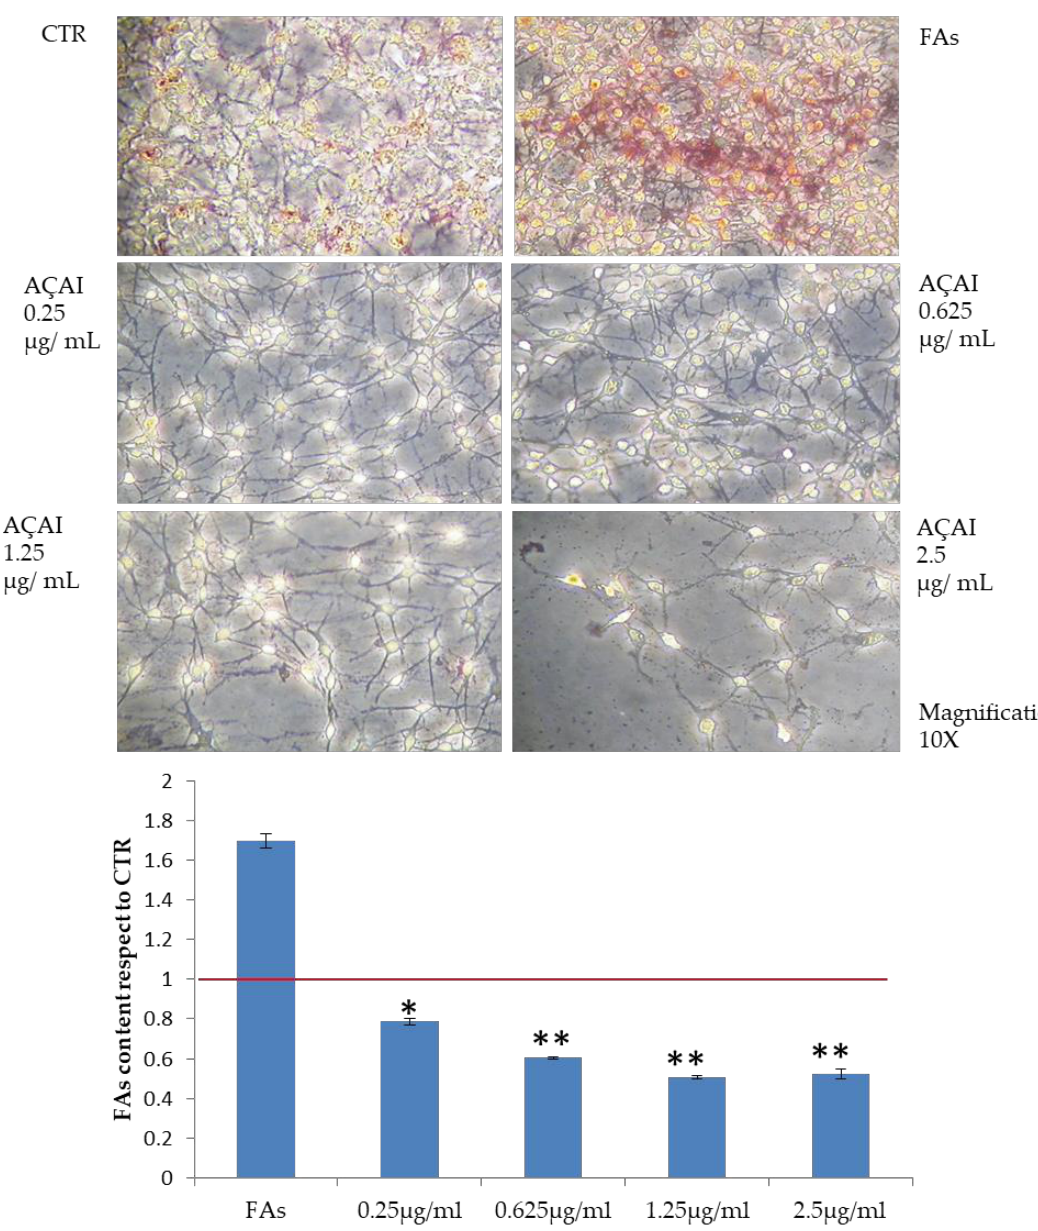
Figure 5. Effects of açai extract on in vitro induced steatosis on HepG2 cells. ( a ) Oil Red O staining images of steatotic HepG2 cells, and control (first image on the left). ( b ) Spectrophotometric quantification of lipids in HepG2 cells treated with açai extract at different concentrations (from 0.25 to 2.5 µ g/mL) with respect to HepG2 control cells. Values are expressed as means ± S.D of independent experiments (n = 3). The red line is relative to control cells. * indicates p < 0.05; ** indicates p < 0.01.